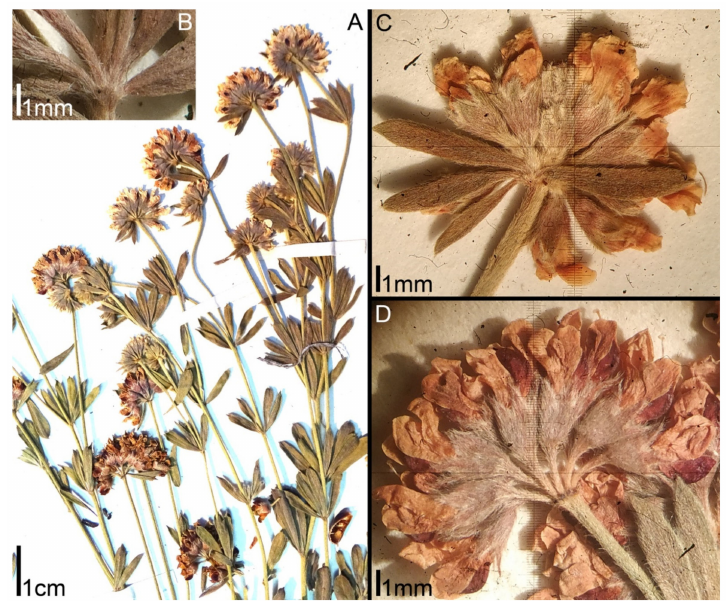
Figure 3. Morphology of Lotus dorycnium ssp. germanicus . Herbarium specimens: Slovakia, J.Ujcik 131 (LE) ( A , B , D ) and Hungary, Illarionova 13 (LE) ( C ): ( A ) fragments of flowering shoots; ( B ) leaf base; ( C , D ) umbels at anthesis.